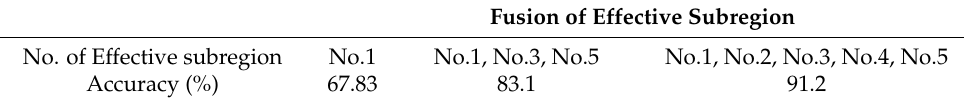
Table 5. Visibility accuracy of fusion of effective subregion.